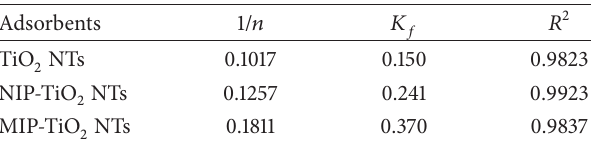
Table 2: Fitting parameters of Freundlich isotherms for PFOA sorption.